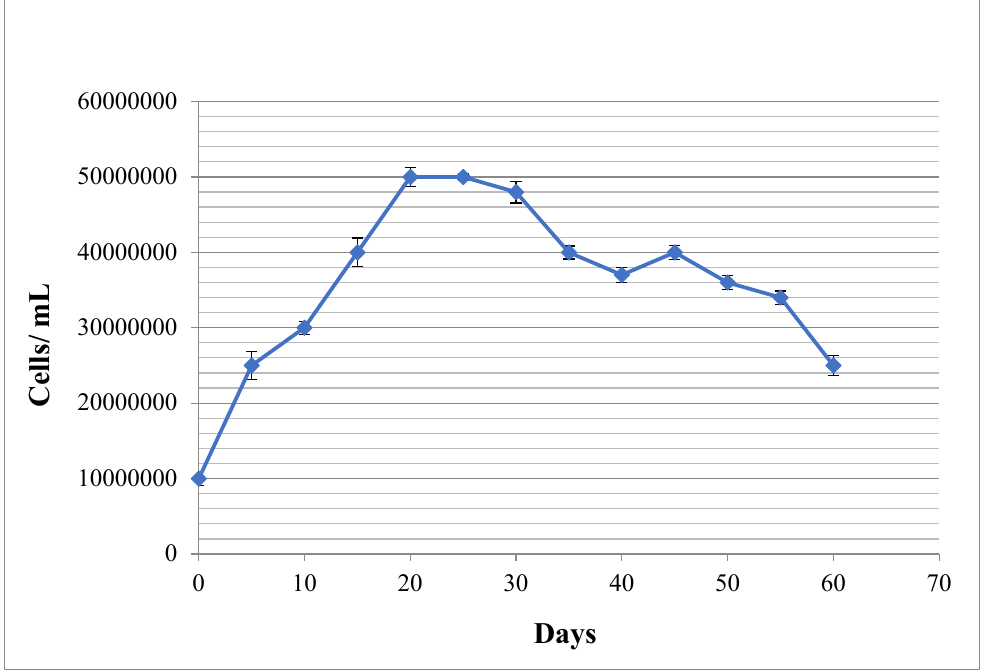
Figure 1. Microalgal growth trend during 60 days of experiment using direct cell counting method. The bars on each dot represent standard deviation of three experiment.